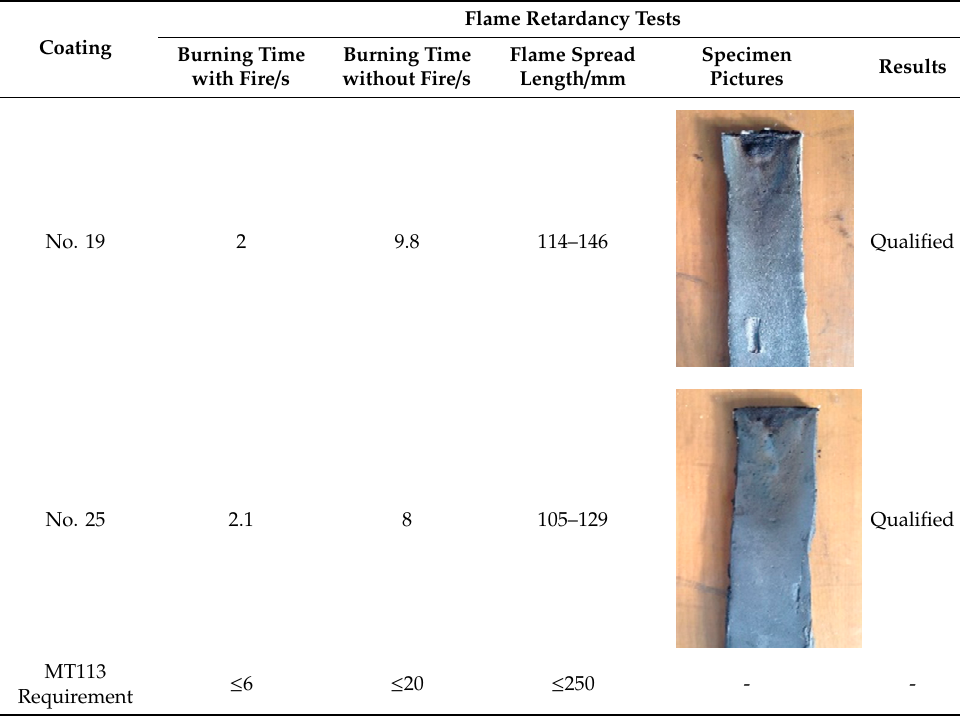
( b ) Figure 7. Impermeability test of ( a ) coating No. 19 and ( b ) coating No. 25. 3.5. Flame ‐ Retardant and Static Electricity Test The gas ‐ sealing materials used in underground coal mines must have a good flame ‐ retardant performance. In organic–inorganic polymer coatings, the emulsion content is the main factor affecting the flame retardancy of the coatings. According to the requirement of MT113 ‐ 1995, the flame retardancy of coatings No. 19 and 25 were tested by the alcohol lamp method. The distance between the test piece and the alcohol lamp was 19 mm. After burning for 90 s, the alcohol lamp was removed and the data shown in Table 3 were recorded. The flame retardancy of both coatings met the requirements of the coal industry standard MT113 ‐ 1995. However, specimen No. 25 had a shorter flame extension length. In addition, a bulge appeared on specimen No. 19 after the burning test, which might be because the emulsion was not dispersed as well in the coating and therefore the